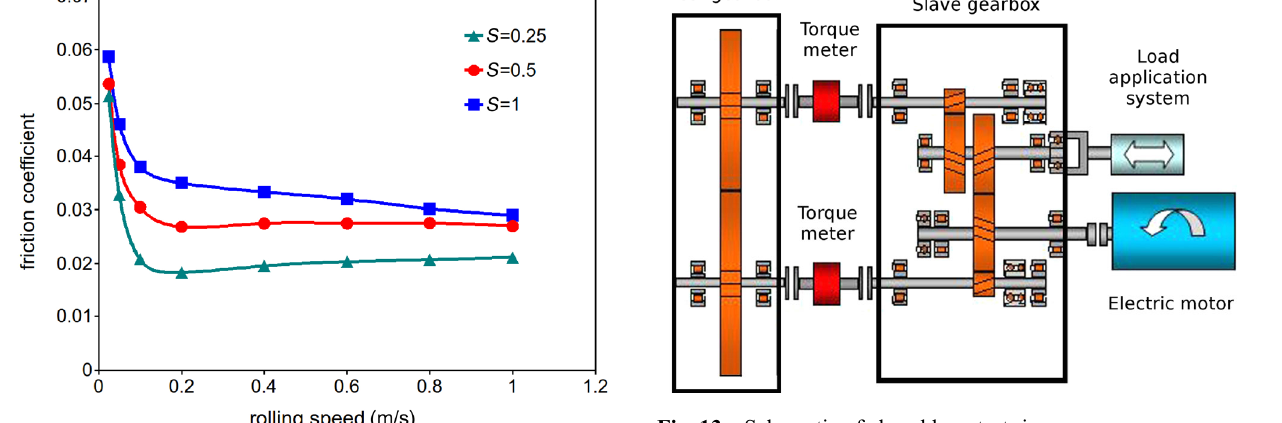
Fig. 13 Schematic of closed loop test rig.